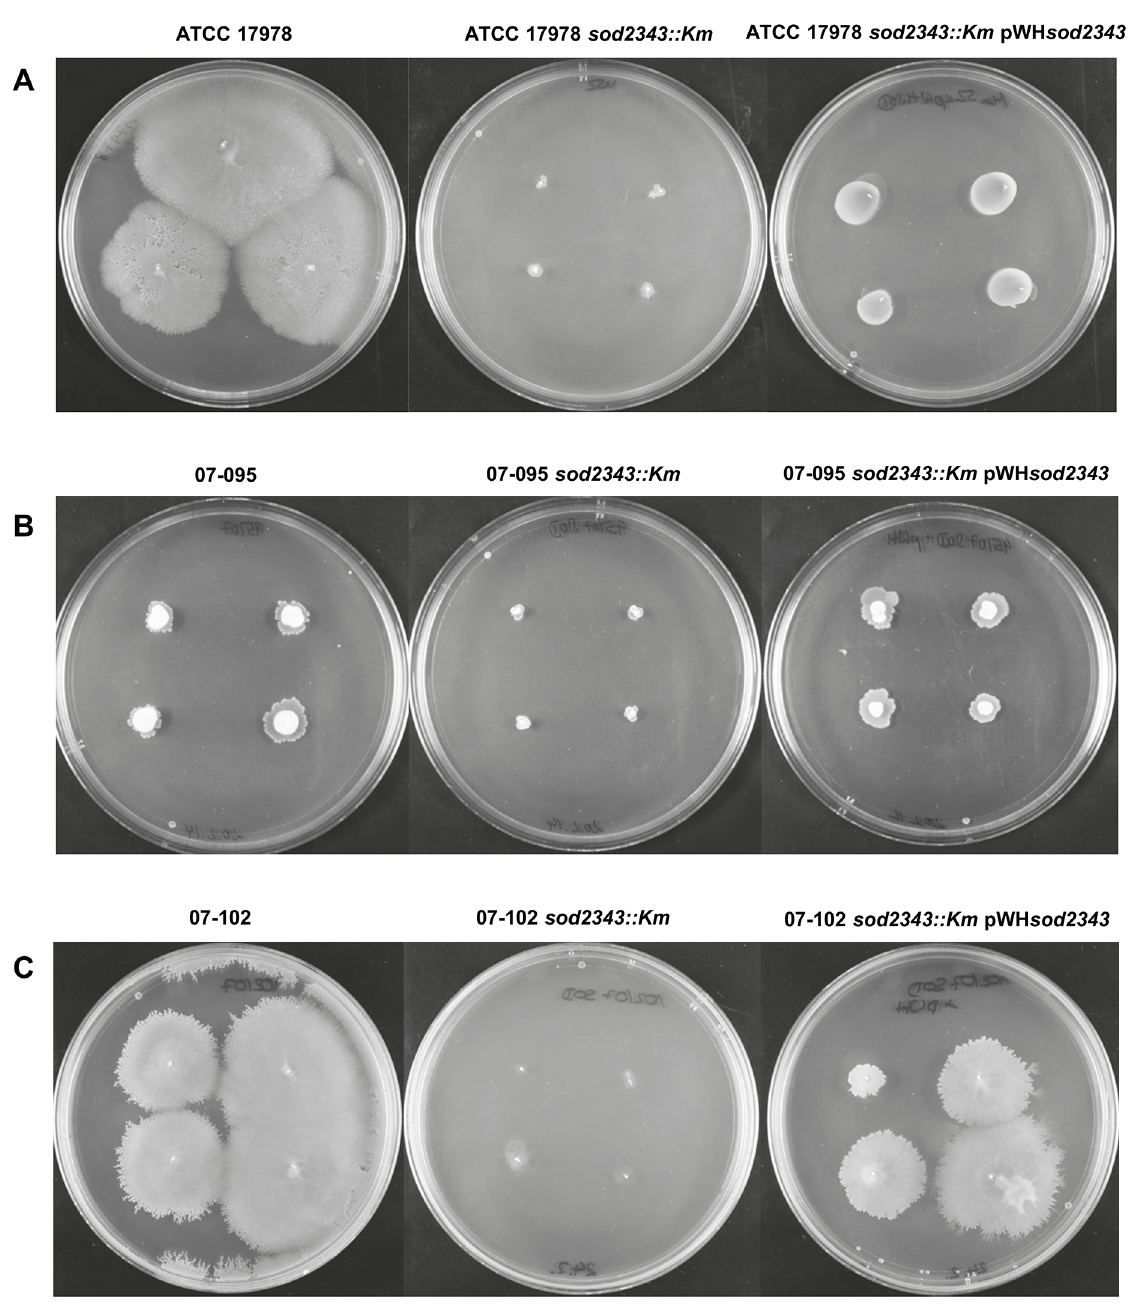
Figure. 3. Motility assays on semi solid agarose plates (0.5%) reveal a motility defect of the sod2343 mutants. (A) ATCC 17978 and ATCC 17978 sod2343::Km . (B) 07–095 and 07–095 sod2343::Km (C) 07–102 and 07–102 sod2343::Km . The pictures shown are representative of three independent replicates.